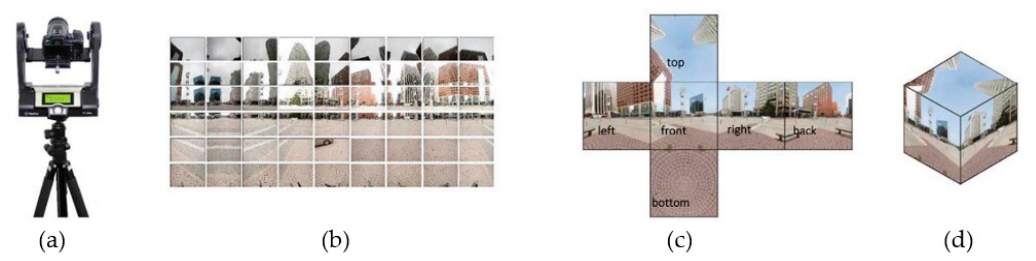
Figure 7. Procedure for creating immersive virtual environments: ( a ) Capturing, ( b ) stitching, ( c ) cube mapping, and ( d ) image wrapping.